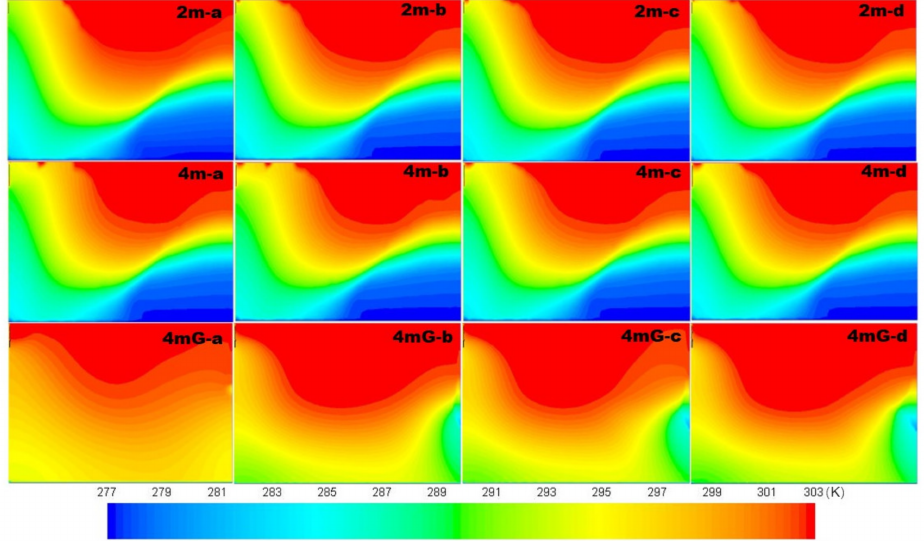
Figure 4. Temperature distribution of different gas inlet velocities. (e.g., a, b, c and d are expressed as 0.03, 0.07, 0.10 and 0.15 m/s, respectively) produced by different lifts (e.g., 2m, 4m and 4mG are expressed as 2m-Lift, 4m-Lift, and 4mG-Lift).